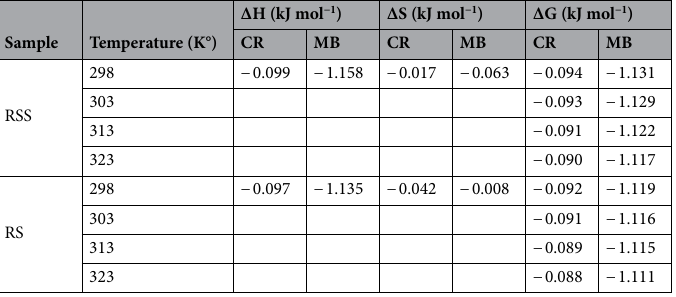
Table 3. Thermodynamic parameters in the adsorption of MB and CR by the PAC adsorbent.